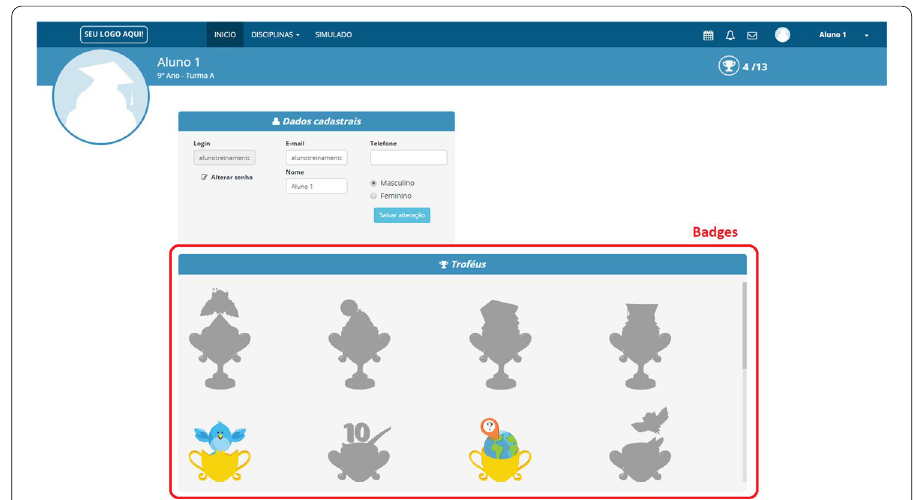
Fig. 6 MeuTutor achiever version (Student